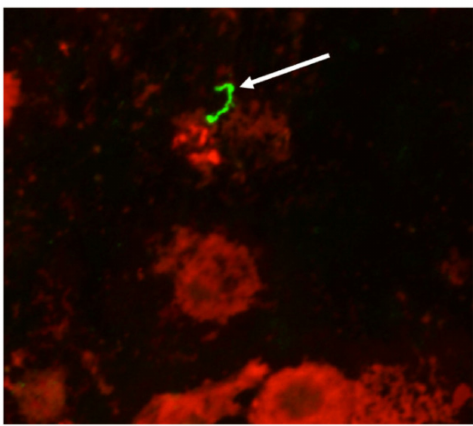
Figure 1. Representative bovine urine sample positive for leptospires by fluorescent antibody test (FAT). Arrow indicates the expected morphology of Leptospira detected in a bovine urine sample. Original magnification 400 ×